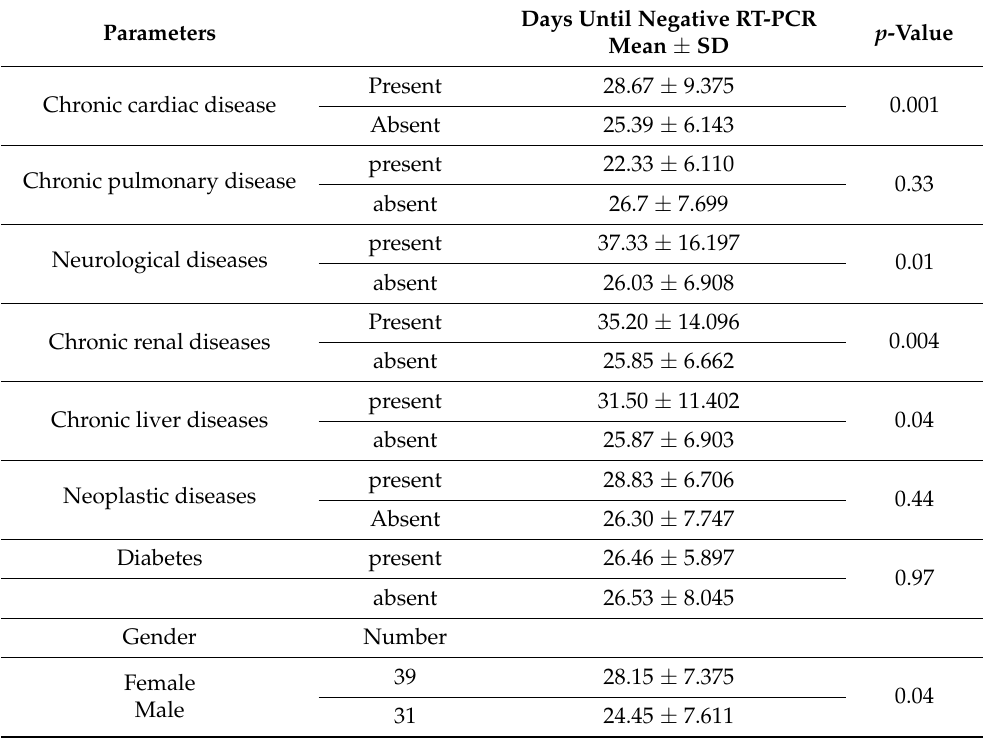
Table 2. Clinical characteristics associated with longer RT-PCR SARS-CoV-2 positive testing.